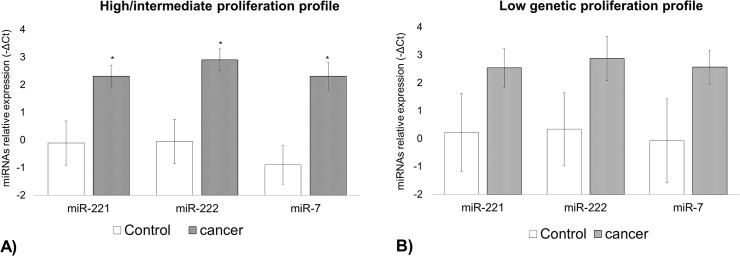
Plasma expression of miR-221, miR222 and miR-7 during the RCC development.Bars indicate mean± standard error of mean. *, P<0.050.